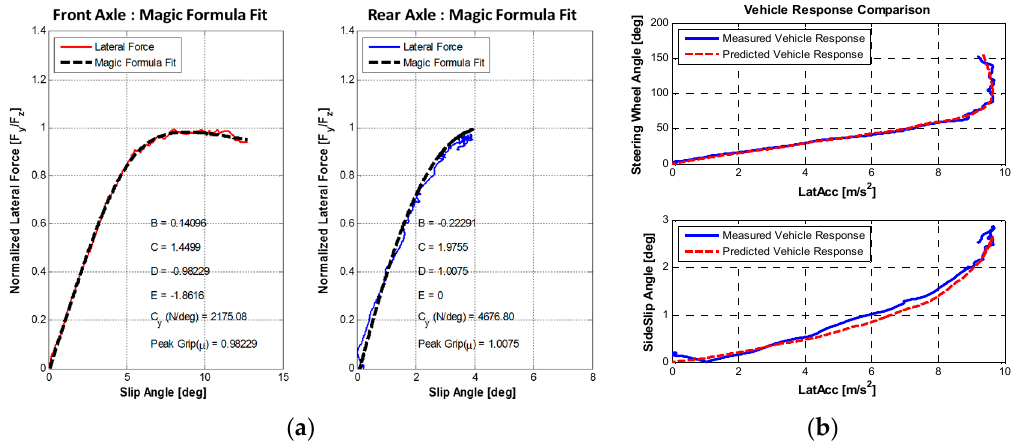
Figure 23. Vehicle axle cornering stiffness identification through steady state tests. ( a ) Axle lateral stiffness identification. ( b ) Fitted model vaidation.